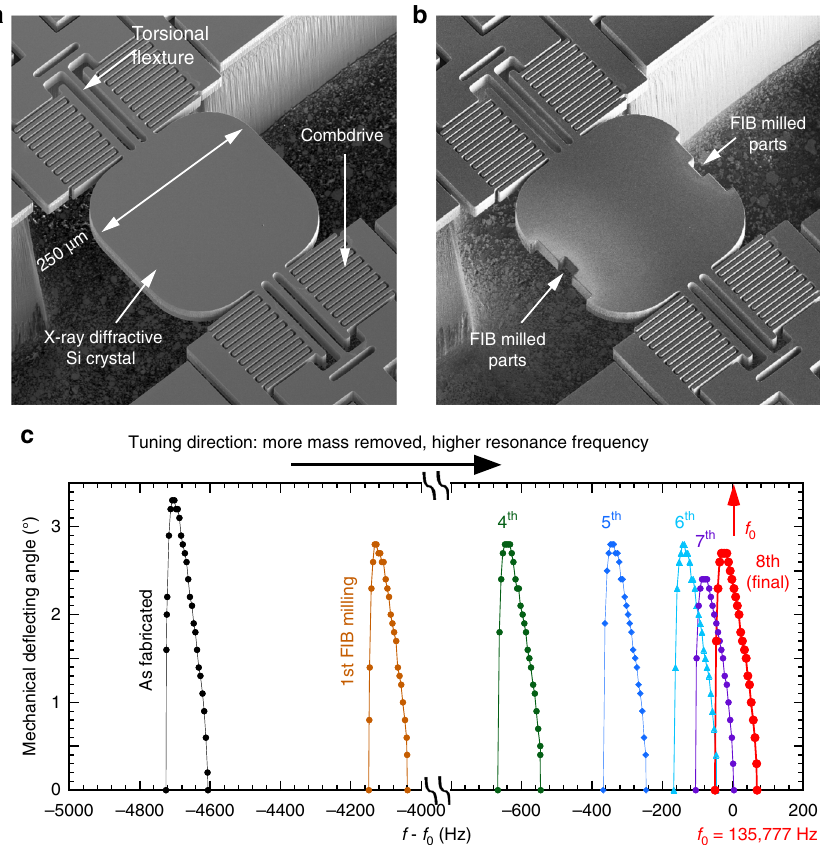
Fig. 2 Tuning the resonance frequency of a MEMS oscillator using focused ion beam (FIB). a b Scanning electron microscopy images of the MEMS device as fabricated and after multiple rounds of FIB micromachining, respectively. Note these FIB machined devices still have the phosphorous dopant- induced strained layers, which was reported in our previous work 29 (more detail in the Supplementary Note 2). c Tuning curves of the MEMS device measured with 45-V (peak-to-valley) square pulses after each FIB micromachining. Note that the frequency denoted in the X-axis is the frequency of excitation voltage signal, or twice the resonance frequency of MEMS devices. A total of eight micromachining processes were performed to tune the device to 135.777 kHz